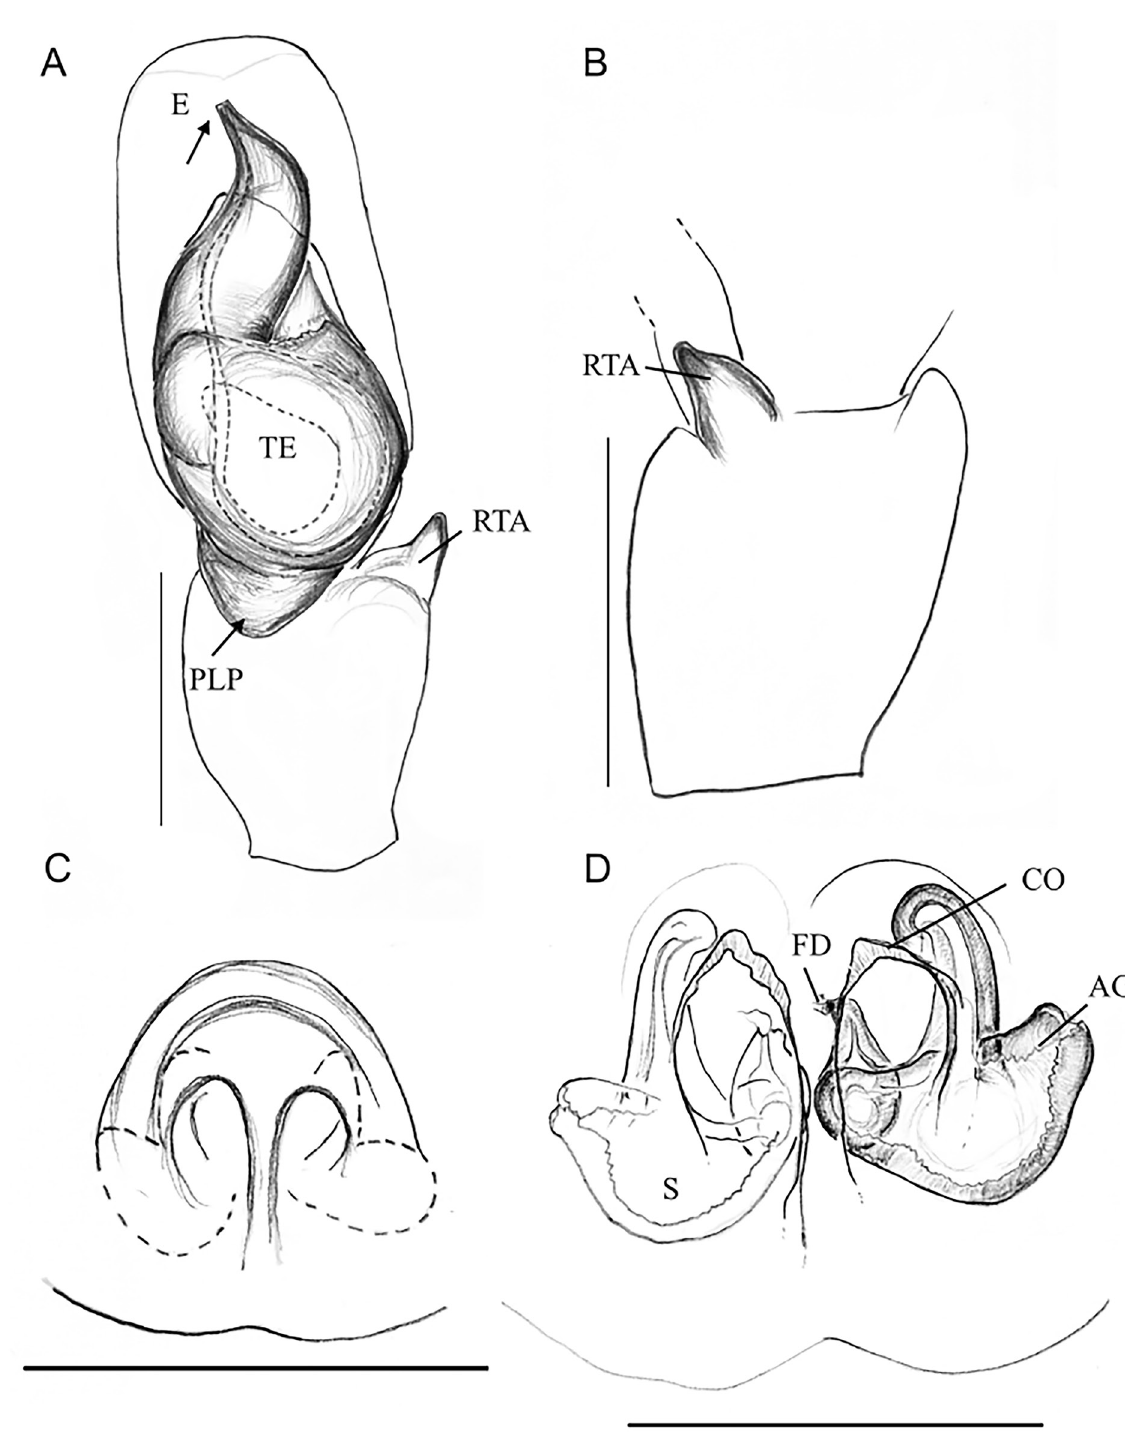
Fig 7. Carrhotus atratus sp. nov. A–B . Palp. A . Ventral view. B . Retrolateral view. C . Epigynum ventral view. D . Vulva dorsal view. Abbreviations: AG = accessory gland; CO = copulatory opening; E = embolus; FD = fertilization duct; PLP = posterior lateral protrusion; RTA = retrolateral tibial apophysis; S = spermatheca; TE = tegulum. Scale bars: A–B = 0.2 mm; C–D = 0.1